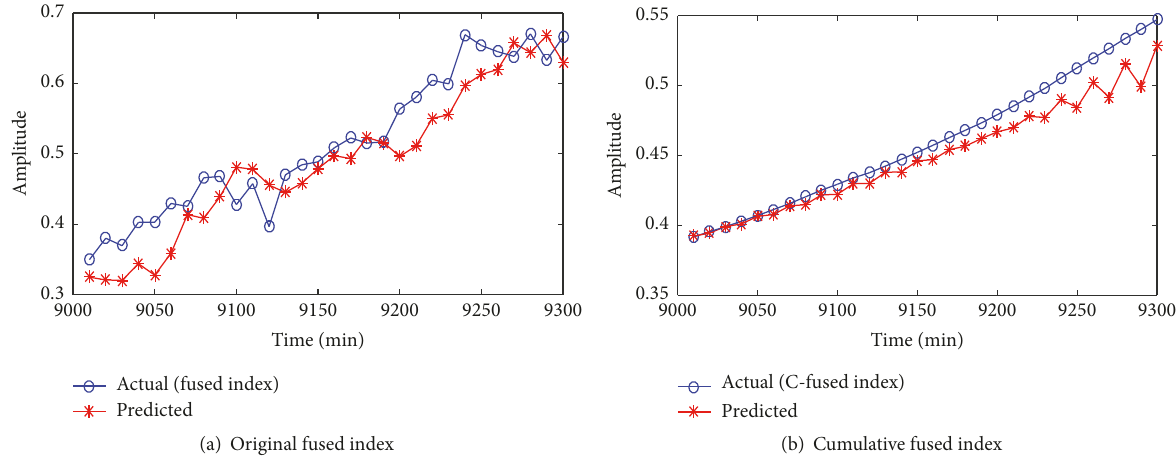
Figure 14: Prediction results of original fused index and cumulative fused index. Table 4: Prediction error comparison of different degradation